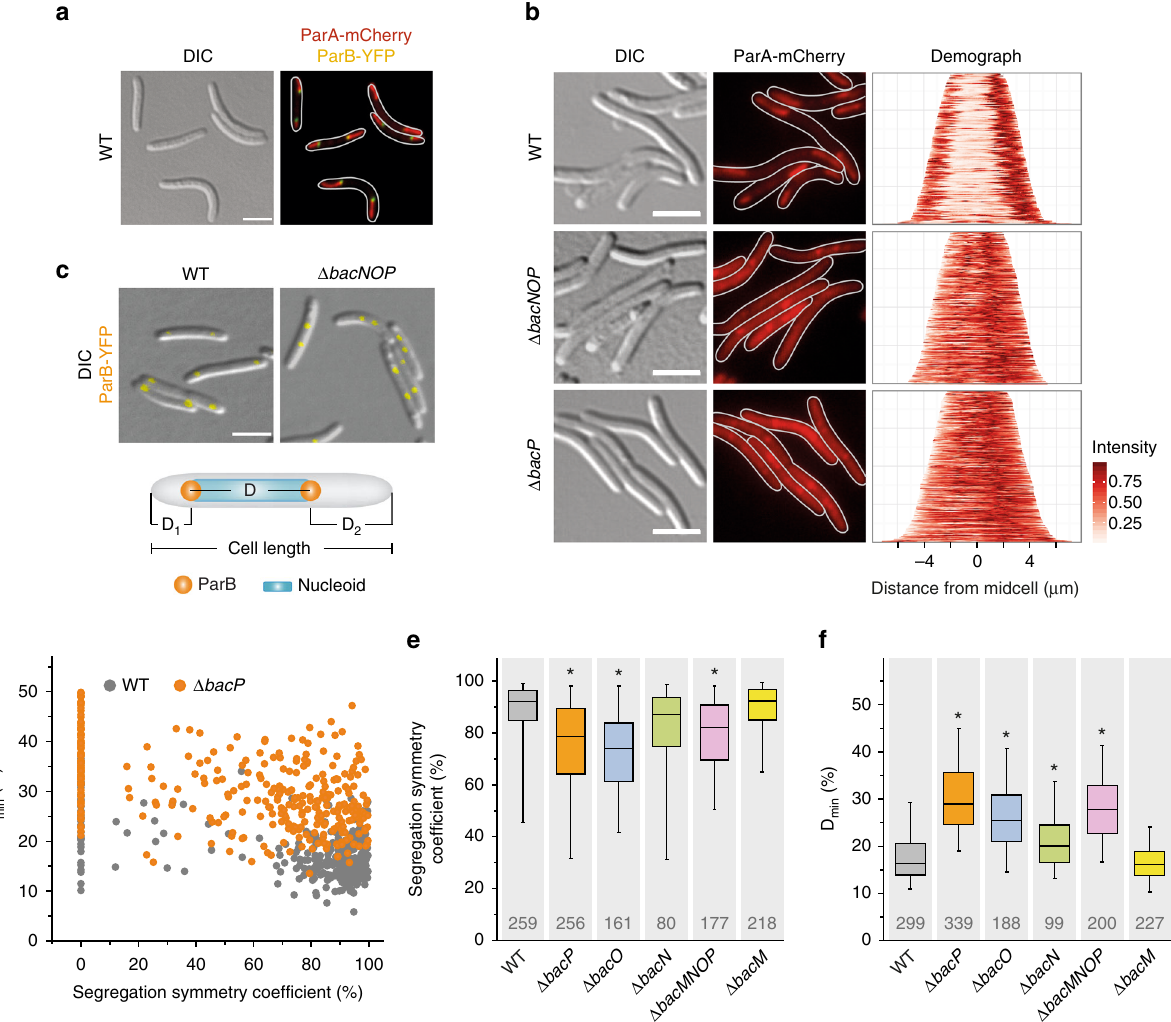
Fig. 2 BacNOP are critical for proper localization of the ParAB chromosome segregation proteins. a Colocalization of ParA and ParB in M. xanthus . Strain LL162 (P parA - parA-mCherry P cuoA -parB-eyfp ) was induced for 20 h with 100 µ M CuSO 4 before imaging. Shown are a DIC micrograph and an overlay of the corresponding mCherry and YFP fl uorescence images (bar: 3 µ m). b Mislocalization of ParA in the absence of BacP. Cells of strains LL145 (P parA - parA- mCherry ), LL147 ( Δ bacNOP P parA - parA-mCherry ) and LL152 ( Δ bacP P parA - parA-mCherry ) were analyzed by DIC and fl uorescence microscopy (bar: 3 µ m). Demographs summarizing the single-cell fl uorescence pro fi les observed for the three strains are given on the right ( n = 166 cells for WT, 187 cells for Δ bacNOP , and 225 cells for Δ bacP ). c Mislocalization of ParB in the absence of BacNOP. Shown are overlays of DIC and fl uorescence micrographs of strains LL012 (P parB - parB-eyfp ) and LL019 ( Δ bacNOP P parB - parB-eyfp ) (bar: 3 µ m). The schematic explains the parameters used for the analysis in panels d – f . d Quantitative analysis of ParB localization in wild-type and Δ bacP populations. Cells of strain LL012 (P parB - parB-eyfp ) and LL015 ( Δ bacP P parB - parB-eyfp ) were analyzed by DIC and fl uorescence microscopy ( n = 299 cells and 339 cells, respectively). Overlays of the images were used to determine the cell lengths and the distances of the ParB-YFP foci from the cell poles (D 1 and D 2 ; see panel c ). The segregation symmetry coef fi cient S indicates how symmetrically ParB-YFP foci are arranged within the cell, with S = D/(D + D2-D1)x100% and D = cell length-D1-D2. D min gives the smallest distance between a ParB-YFP focus and a cell pole normalized to cell length, with D min = D 1 /cell length × 100%. Note that, by de fi nition, S = 0 % for cells containing only a single ParB- YFP focus. e and f Aberrant segregation and positioning of the ParB · origin complexes in the absence of bacto fi lins. The segregation symmetry coef fi cient e and D min f were determined for strain LL012 (P parB - parB-eyfp ) (WT) and its derivatives LL015 ( Δ bacP ), LL018 ( Δ bacO ), LL014 ( Δ bacN ), LL016 ( Δ bacM Δ bacNOP ), and LL013 ( Δ bacM ). The data are represented by box plots. The center line shows the median, the box limits indicate the 25th and 75th percentile, and whiskers extend to the 5th and 95th percentile. Only cells containing two ParB-YFP foci were considered in panel e . The number of cells analyzed for each strain is given underneath the plots. Signi fi cant differences between the wild-type and mutant strains are indicated by asterisks ( p < 0.0001; Mann – Whitney